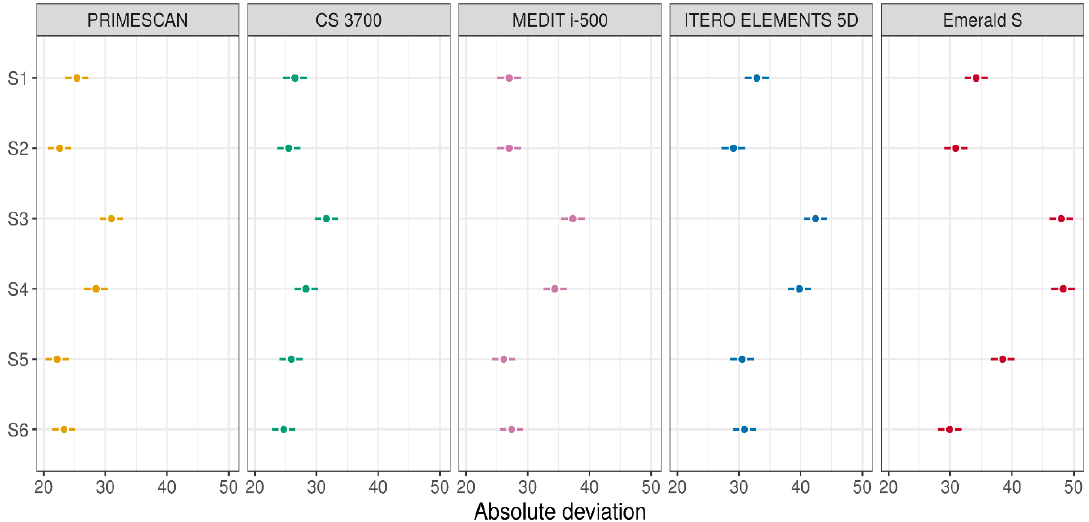
Figure 7. Mean absolute deviations estimates (with 95% confidence intervals) for SBs in each group of IOSs (these quantities were estimated using two-way ANOVA).